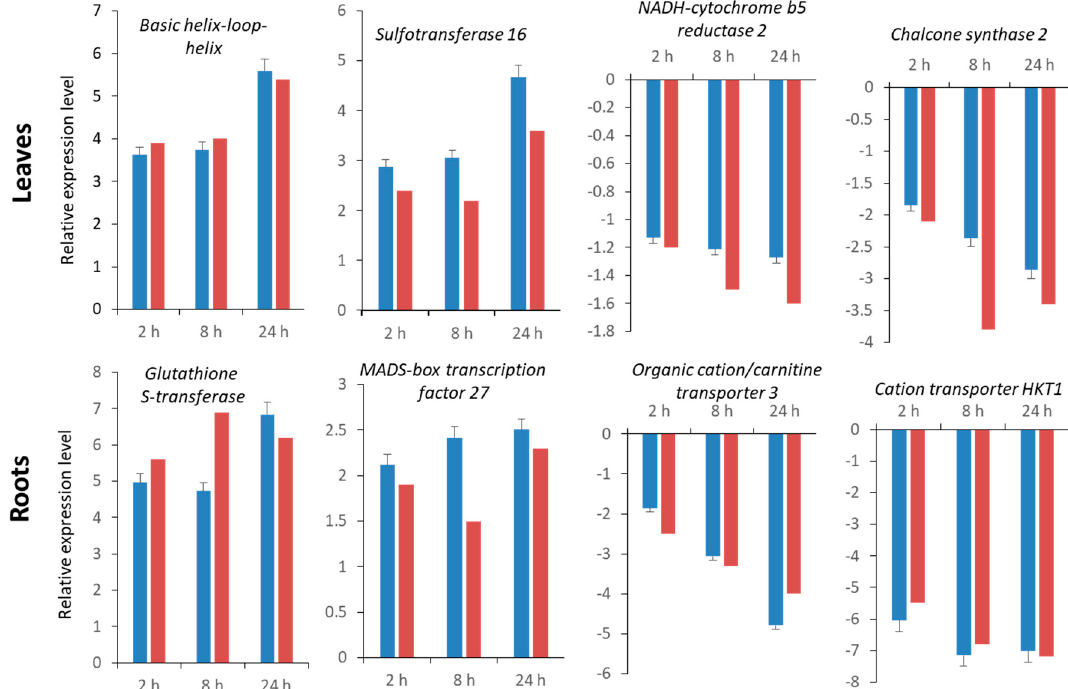
Figure 5. Expression pattern validation of eight randomly selected genes in leaves and roots by qRT-PCR. Red bar indicates transcript abundance changes of RNA-seq data calculated by the Log 2 fold change method. Blue bar, mean with associated standard error bar ( n = 3), represents the relative expression level determined by qRT-PCR using the 2 −ΔΔ CT method.